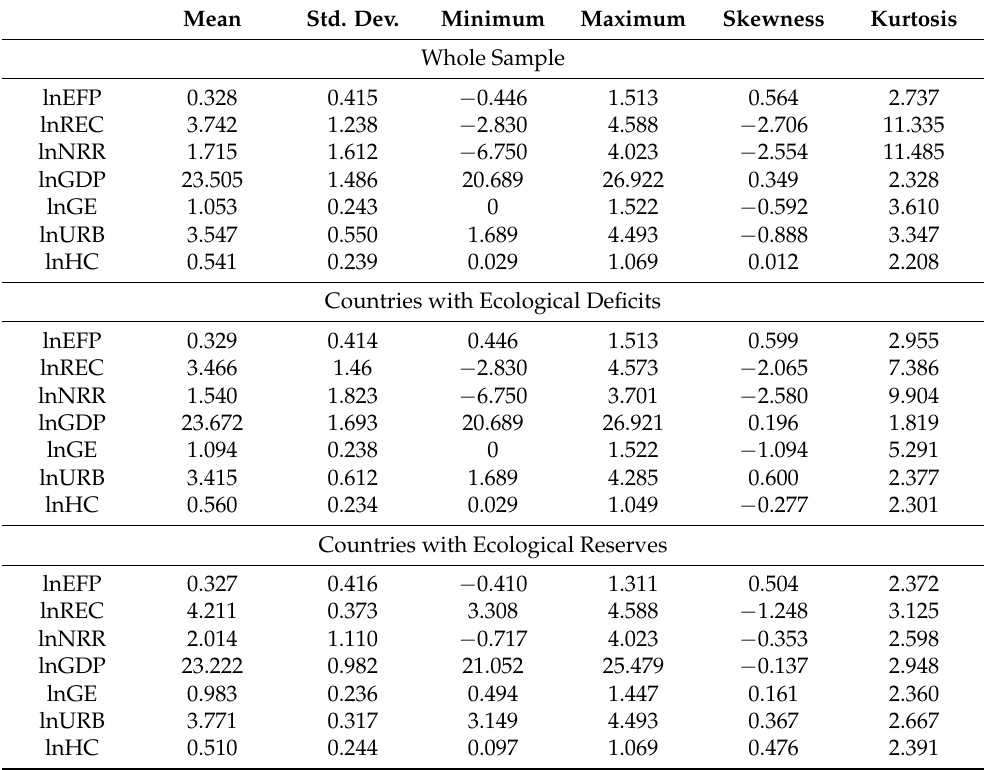
Table 2. Descriptive statistics of variables.